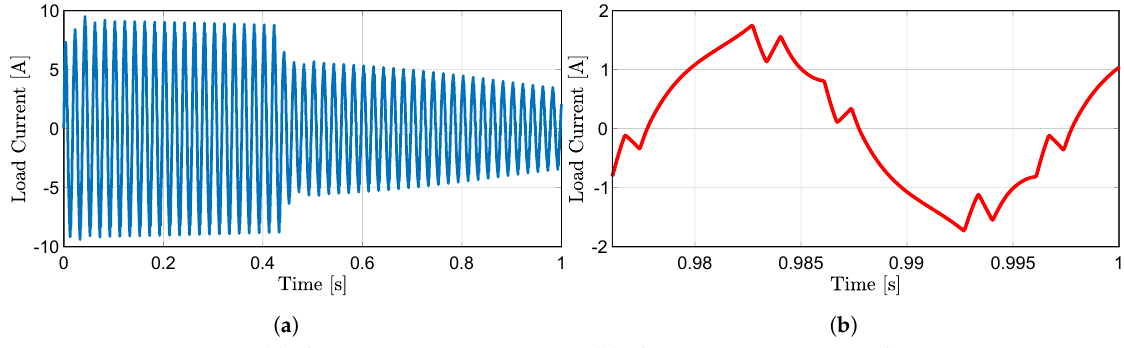
Figure 7. ( a ) The motor current in start up; ( b ) The motor current in steady